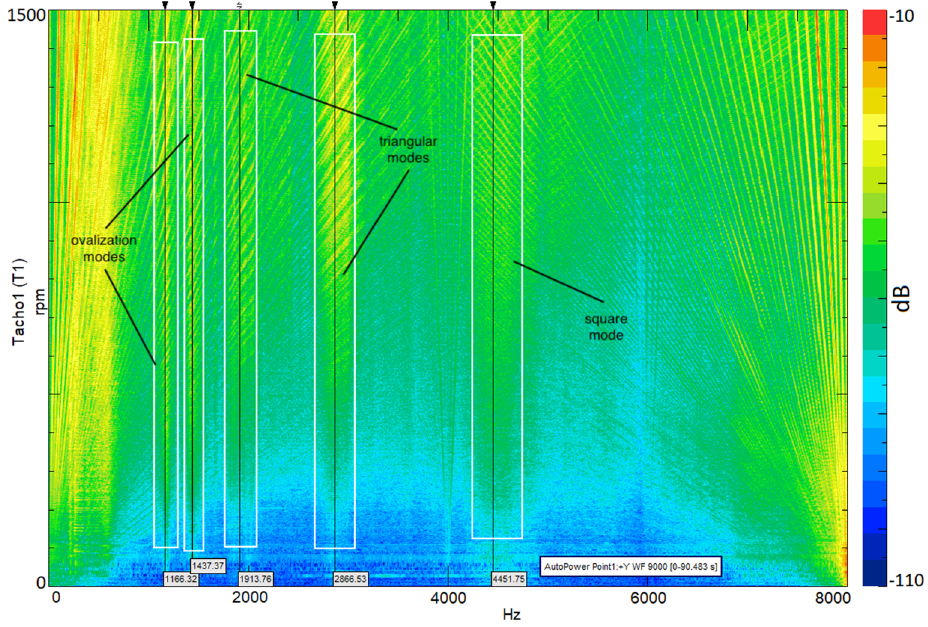
Figure 16. Vibration signal frequency spectrum with natural mode frequencies marked .